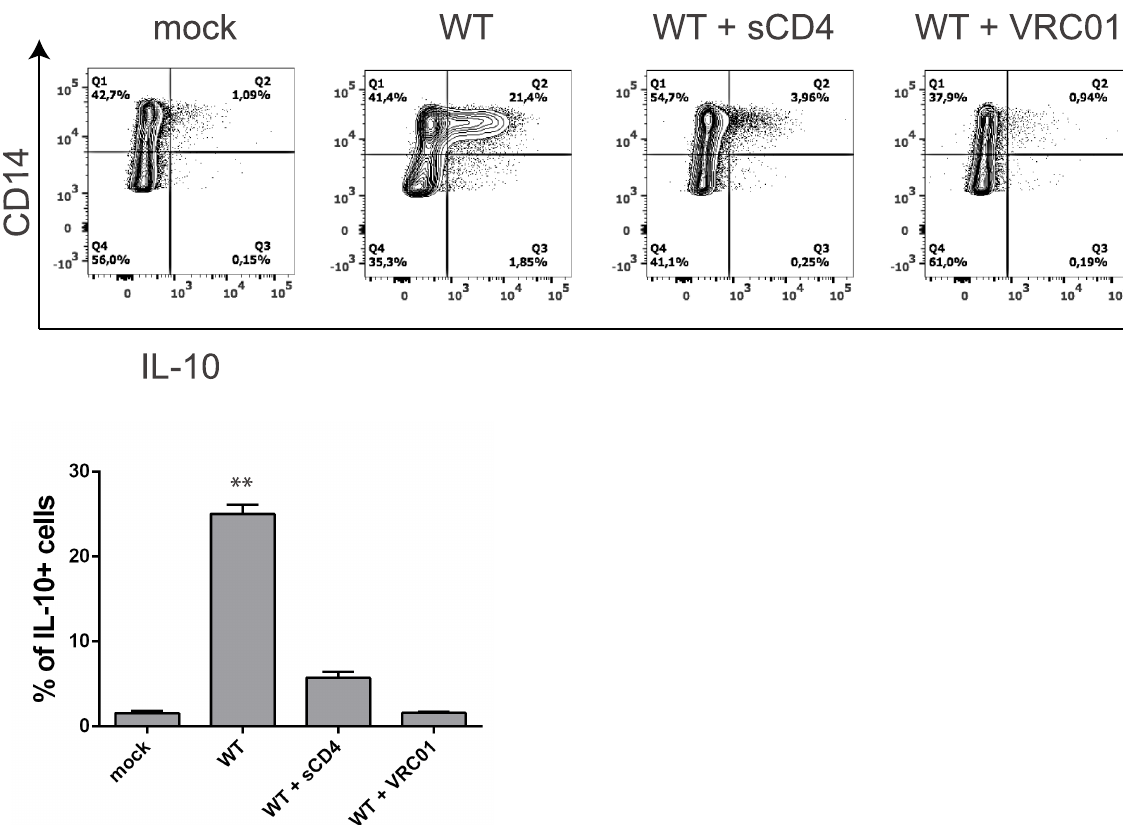
Fig 3. Blockade of gp120 CD4-binding site inhibits IL-10 production by monocytes. A) Representative experiment and B) flow cytometry analysisof IL-10 expression on PBMC CD3- CD14+ cells detected by intracellular stainingafter gp120 stimulationin absenceor presenceof sCD4 or the CD4-binding site VRC01 antibody at a molar ratio of 1:1 with gp120. Statistical analysiswere performed with t-tests to compare to the mock control ( ** p < 0.01).